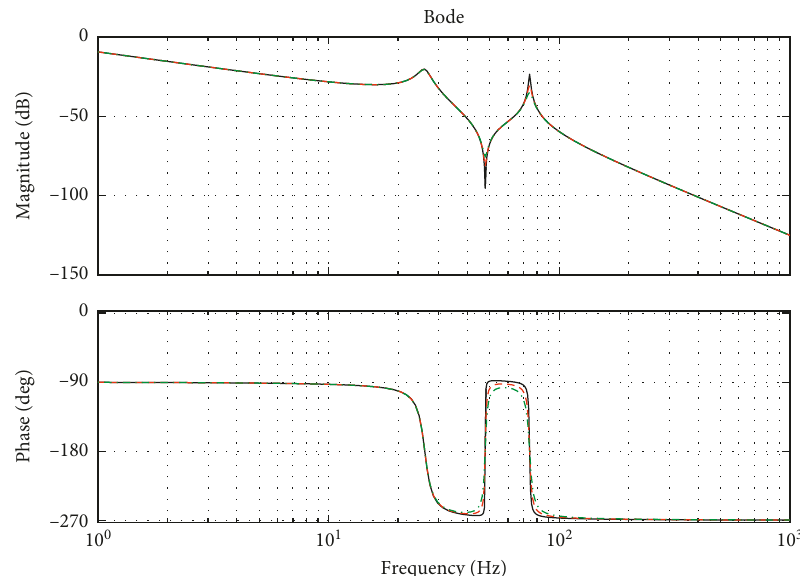
Figure 10: The open-loop Bode diagram of different viscous damping coefficients of load.